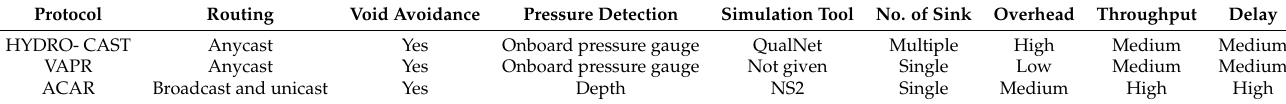
Table 13. Comparison of Pressure-Based Routing